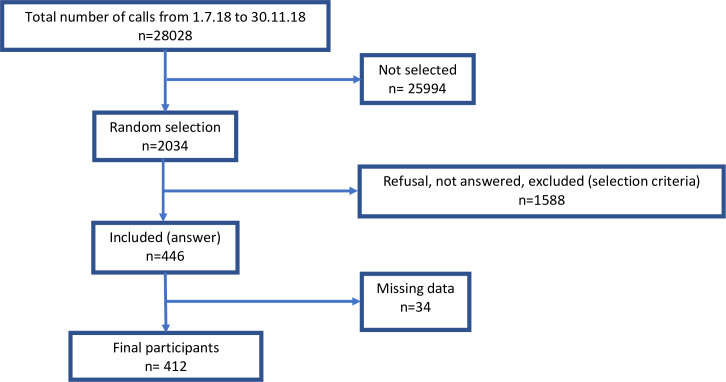
Flowchart of inclusions.